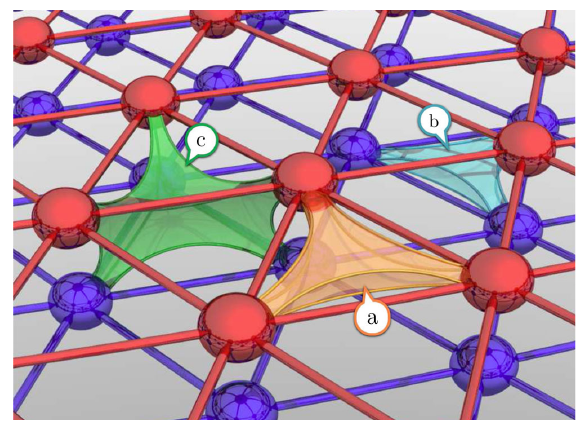
FIG. 4. For topological color codes, qubits are arranged on trivalent lattices (hexagonal or square-octagonal). These codes are mapped to triangular lattices (triangular and union jack, respectively) with plaquette interactions (a),(b) on each layer, as well as six-body interactions correlating the two layers